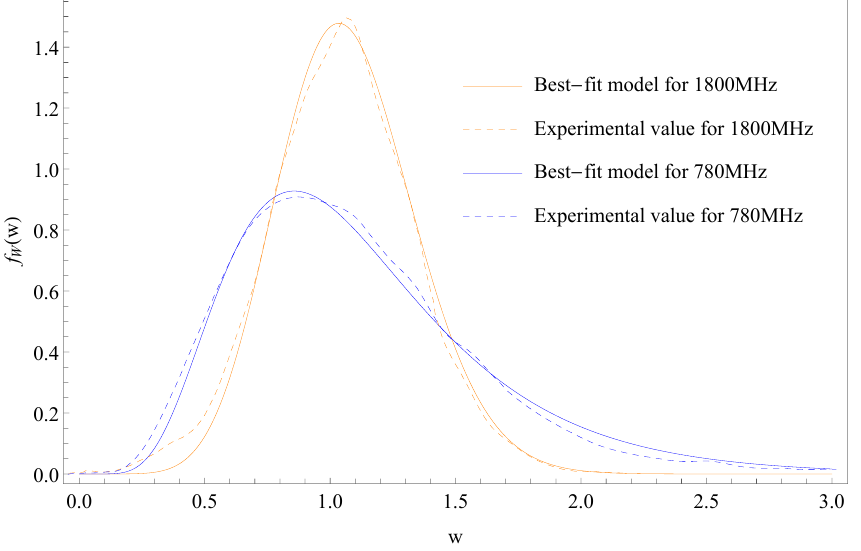
Figure 6. Empirical and Fitted PDFs for field